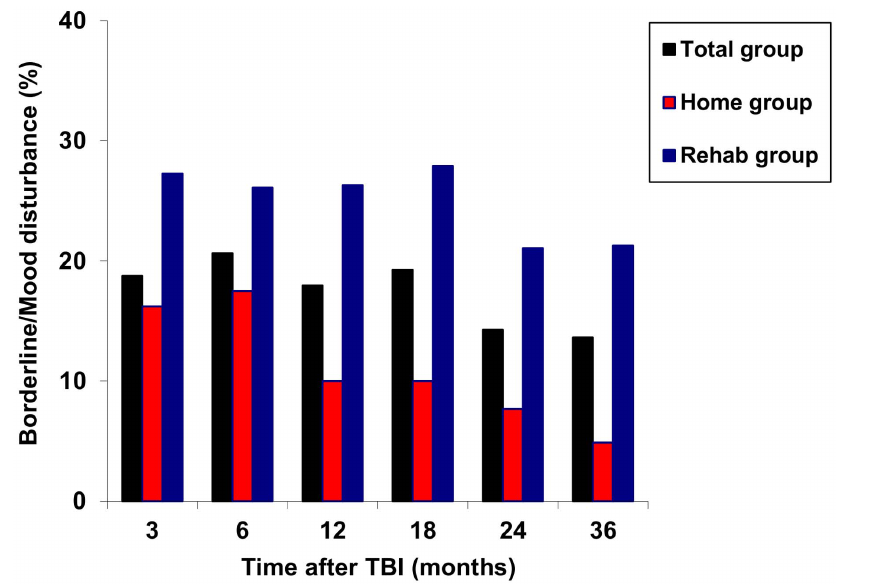
Figure 3. Proportion of patients with a mood disturbance in the Rehab group (blue; n=53), Home group (red; n=45) and total group (black; n=98) over